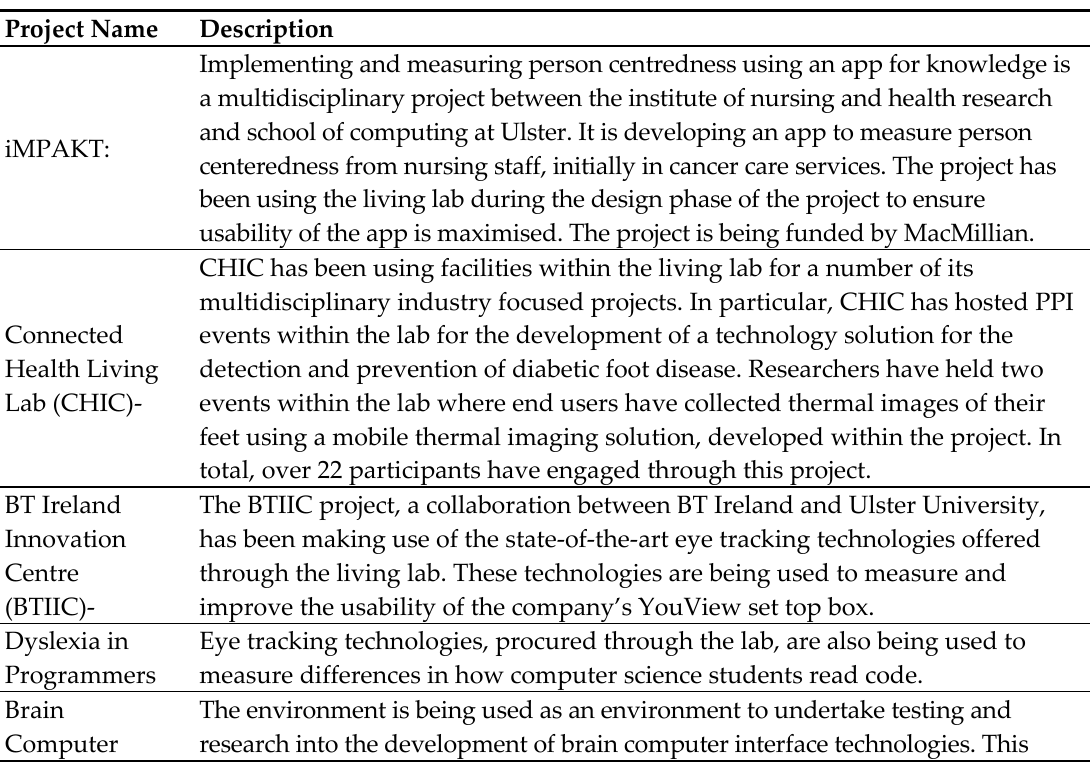
Table 2. Collaborative project involving the living